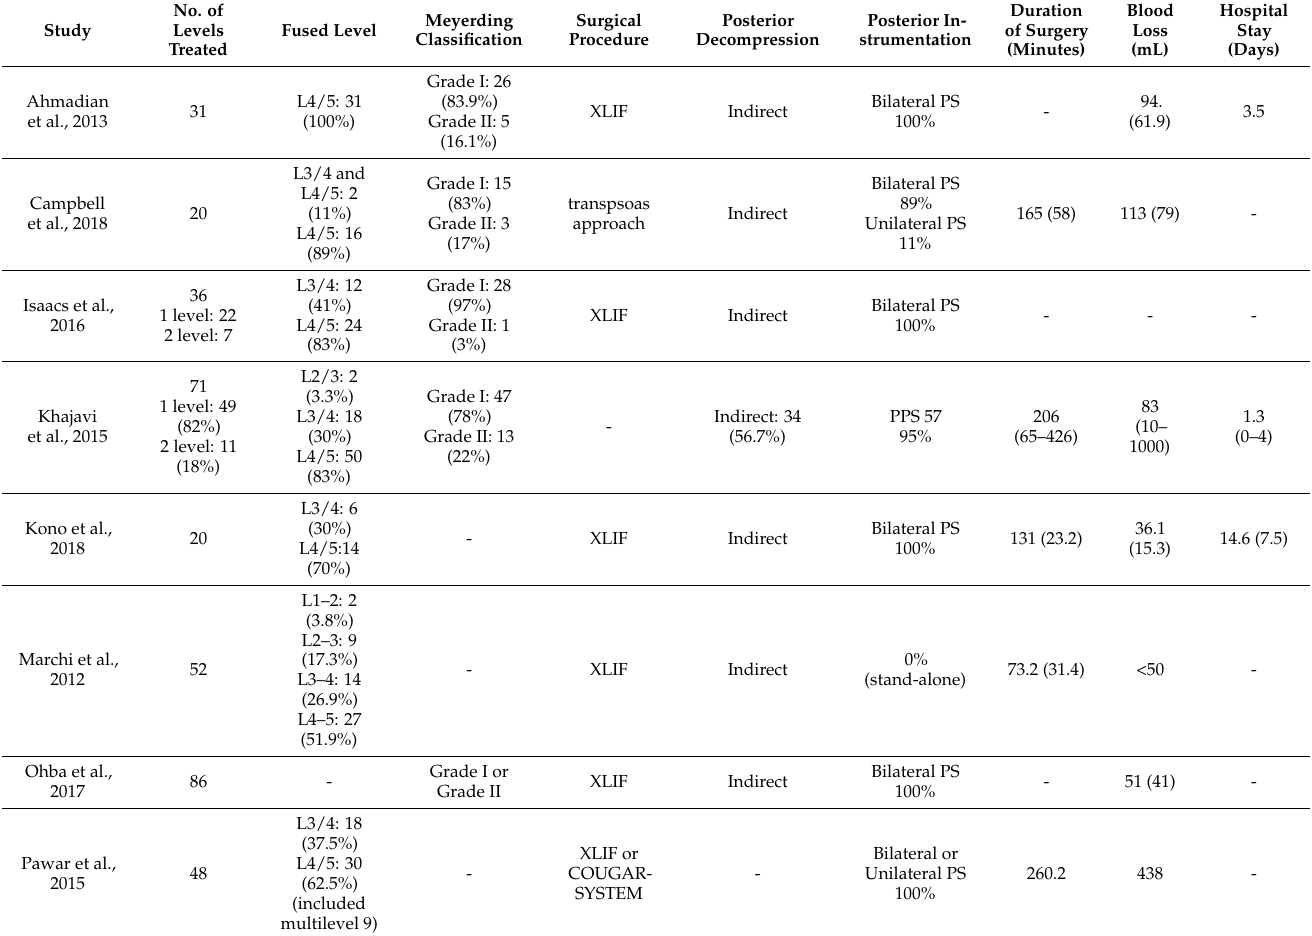
Table 2. Available surgical data extracted from the included